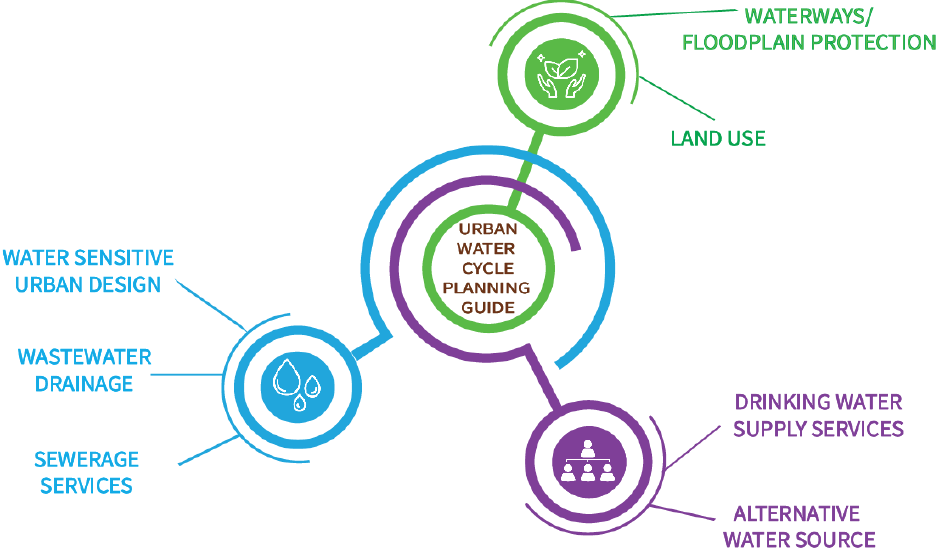
Figure 14. IWCM components in a UWCG process.